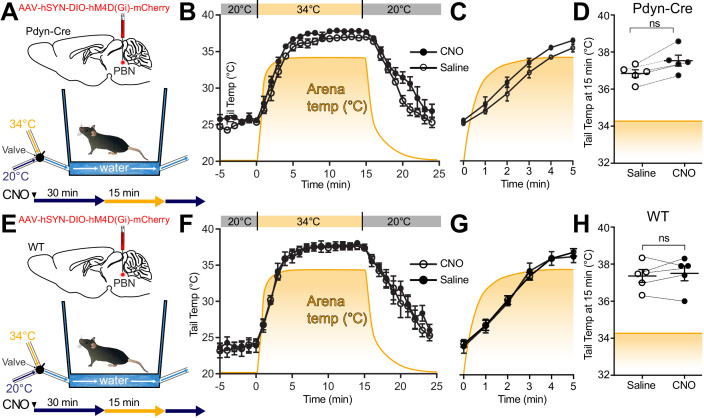
Gi DREADD mediated inhibition of Pdyn+ parabrachial nucleus (PBN) neurons does not block thermal challenge evoked tail vasodilation and CNO in WT mice does not alter responses to warmth challenge.(A and E) Illustrations depict viral injections in Pdyn-Cre or WT mice and arena that allowed for rapid changing of environmental temperature between two stable set points. Tail temperature vs. time graph for 34°C heat challenge for (B) Pdyn-Cre or (F) WT mice. Heat challenge was delivered from t = 0 to t = 15 min, and arena temperature throughout the trial is displayed by the orange line. In mice injected with CNO 2.5 mg/kg or in mice injected with saline, tail temperature rose above arena temperature after 4–5 min of heat challenge. Data are presented as mean ± SEM. n = 5 animals, paired between CNO and saline conditions. Tail temperature vs. time graph for 34°C heat challenge between t = 0 and t = 5 min for Pdyn-Cre (C) or WT (G) mice. Note the overlap between average tail temperatures of the saline condition vs. the CNO condition across time. Data are presented as mean ± SEM. n = 5 animals, paired between CNO and saline conditions. (D and H) Tail temperature at t = 15 min of 34°C heat challenge. The average difference between tail temperatures in the saline condition and those in the CNO condition was not significantly different. For Pdyn-Cre mean difference ± SEM was 0.18 ± 0.22 (p=0.46). For WT mean ± SEM difference 0.14 ± 0.24°C (p=0.59). Data are presented as mean ± SEM. n = 5 animals in each group, paired between CNO and saline conditions for both Pdyn-Cre and WT.